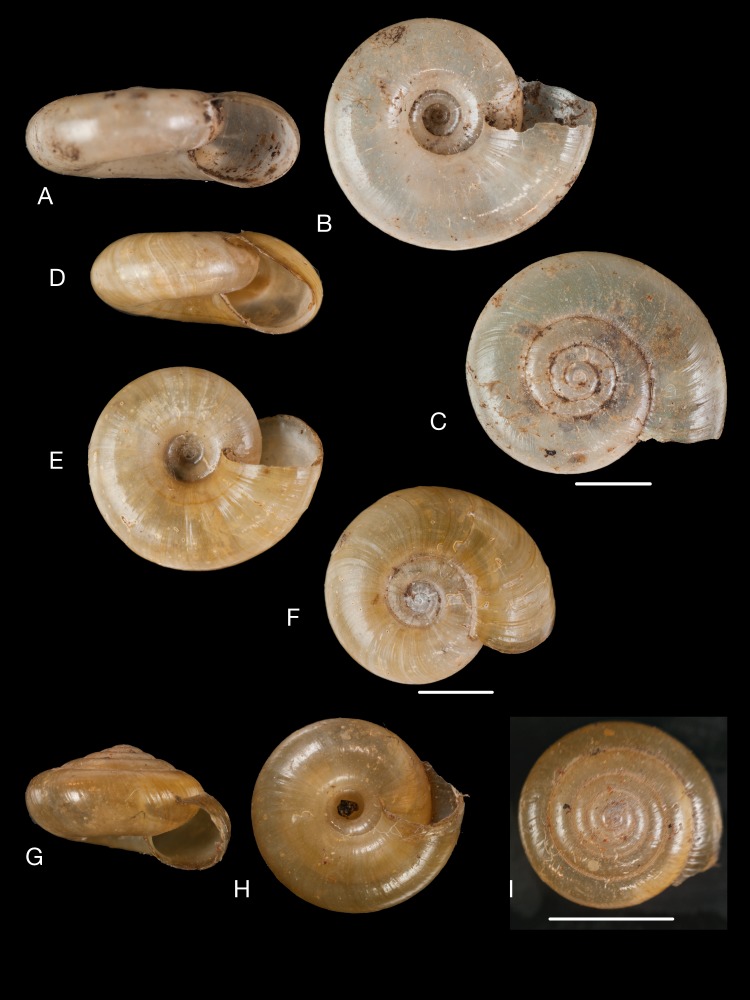
Material collected by the CCP.(A–I) Scolodontidae. Happia cf. cuzcana (Philippi, 1869), MNCN 15.05/3304, (A) ventral view, (B) umbilical view, (C) apical view; Happia vitrina (Wagner, 1827), MNCN 15.05/12959, (D) ventral view, (E) umbilical view, (F) apical view; Prohappia besckei (Dunker, 1847), MNCN 15.05/12578, (G) ventral view, (H) umbilical view, (I) apical view. Scale line 5 mm.